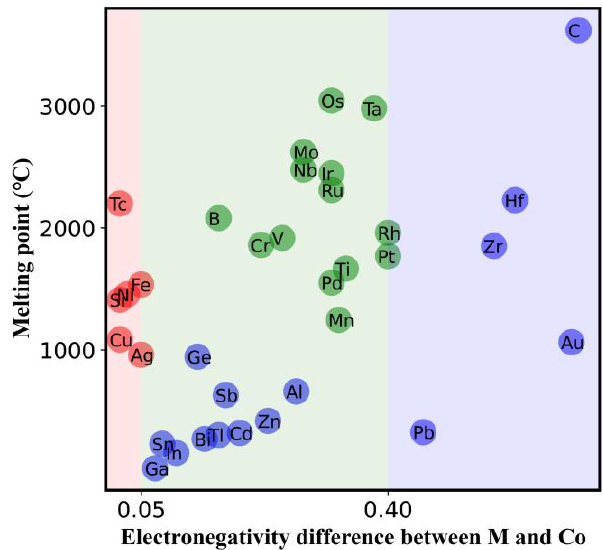
Figure 7. Classification of the doping elements based on their T m and | χ Co − χ M | . The elements in red can promote the formation of the 1:7 H single phase, and the elements in blue can only stabilize the 1:7 H phase in a narrow doping amount and grain size range. The doping elements in green have the largest critical grain size for phase decomposition at doping amounts between 0.5 and 0.7.